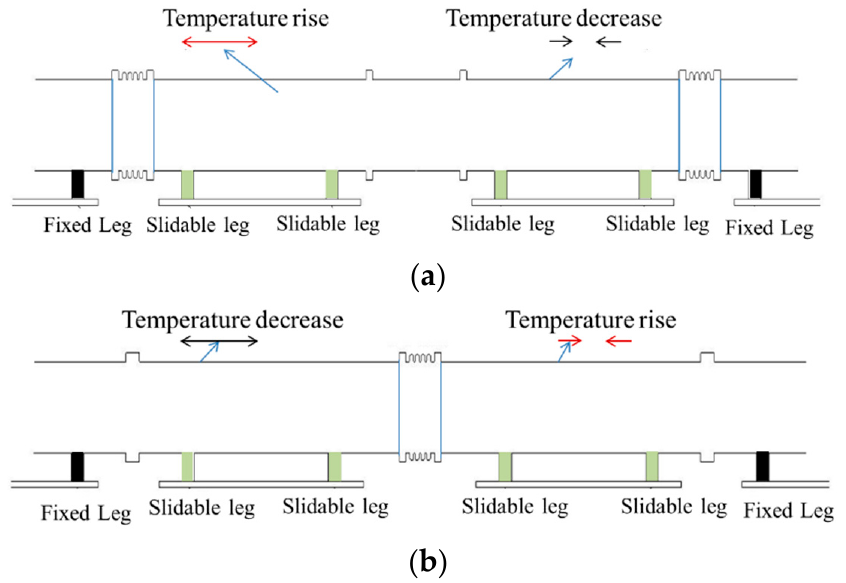
Figure 3. Arrangement of bellows in GIS: ( a ) distributed layout; ( b ) centralized layout. Due to the different compression and tensile directions of bellows in the two layout schemes, there are some differences in the compression (elongation) and maximum stress of bellows in the same temperature fluctuation range. At the same time, the support legs of most GIS equipment are mainly located below the shell and are in contact with the ground. The support legs of a few GIS devices are located behind the shell and in contact with the wall. Therefore, compared with the side of the bellows close to the support legs, the side further from the support legs is less constrained in the process of compression and elongation, which leads to differences in the amount of compression (elongation) and maximum stress at the upper and lower ends or front and rear ends of the